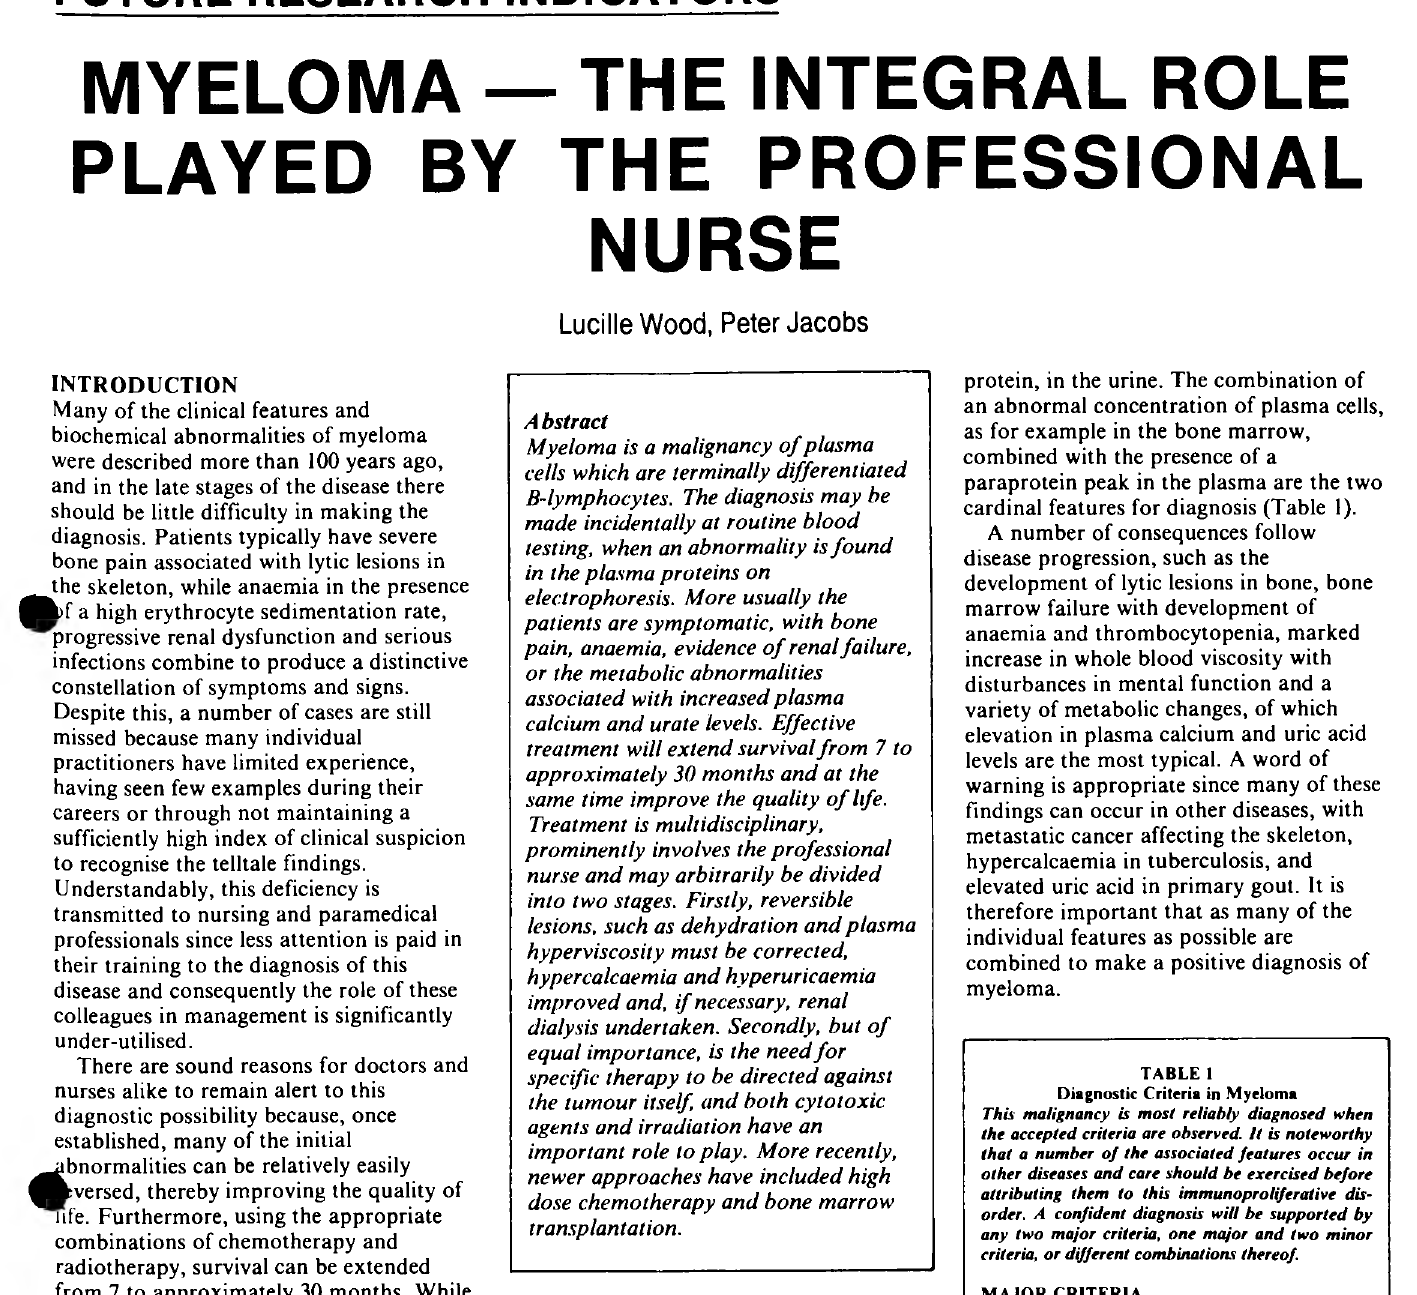
MAJOR CRITERIA 1. Plasmacytoma on tissue